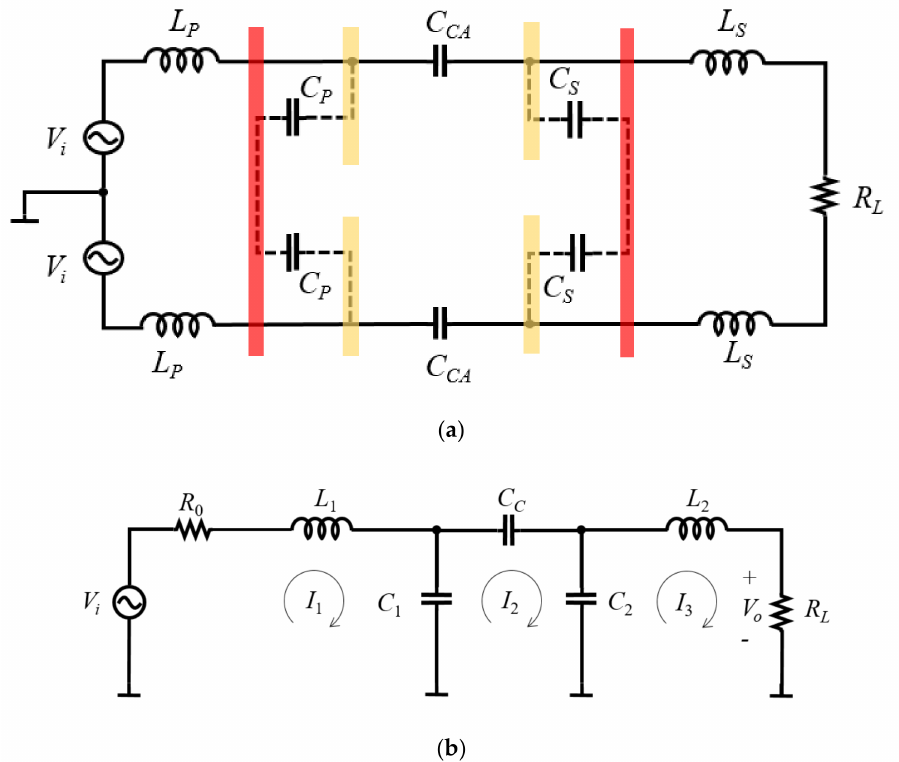
Figure 2. S-CPT diagram. ( a ) Symmetrical S-CPT circuit. ( b ) Equivalent circuit of the symmetrical S-CPT circuit.